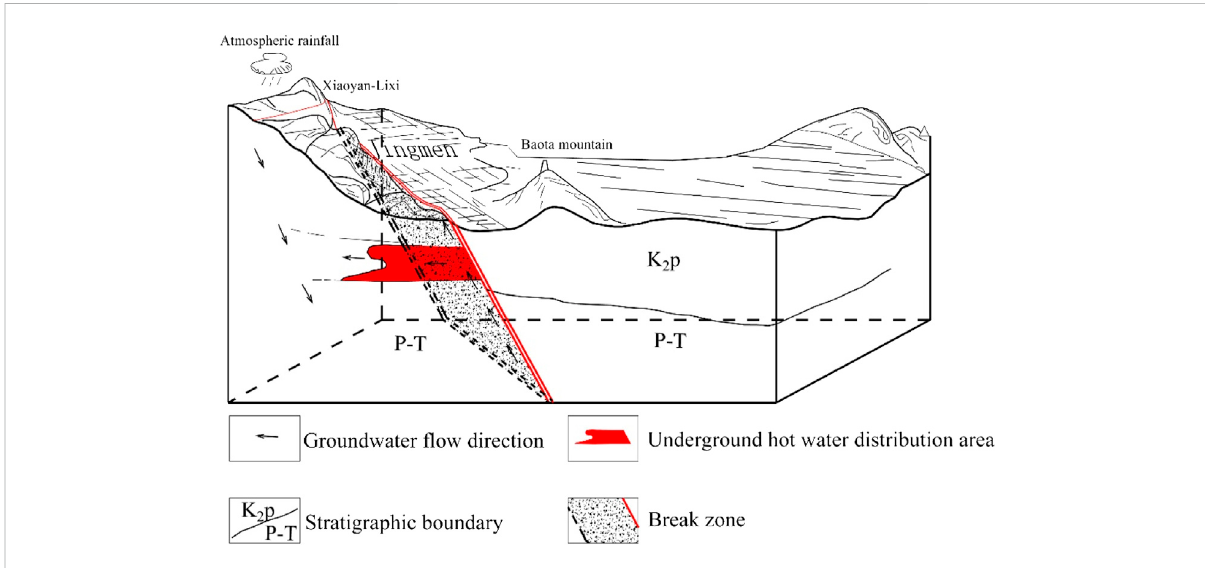
FIGURE 9 Genetic model of a geothermal system in the urban area of Jingmen. (K 2 p: The upper cretaceous paomagang Formation; P: Permian; T: